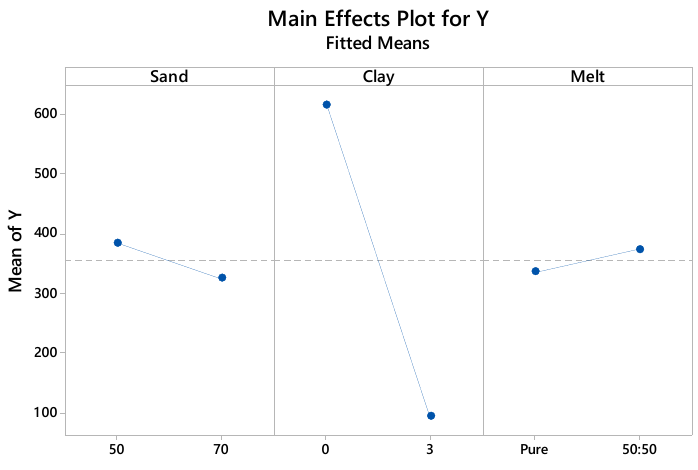
Figure 9. Effect of process parameters on defect formation. Figure 9. E ff ect of process parameters on defect